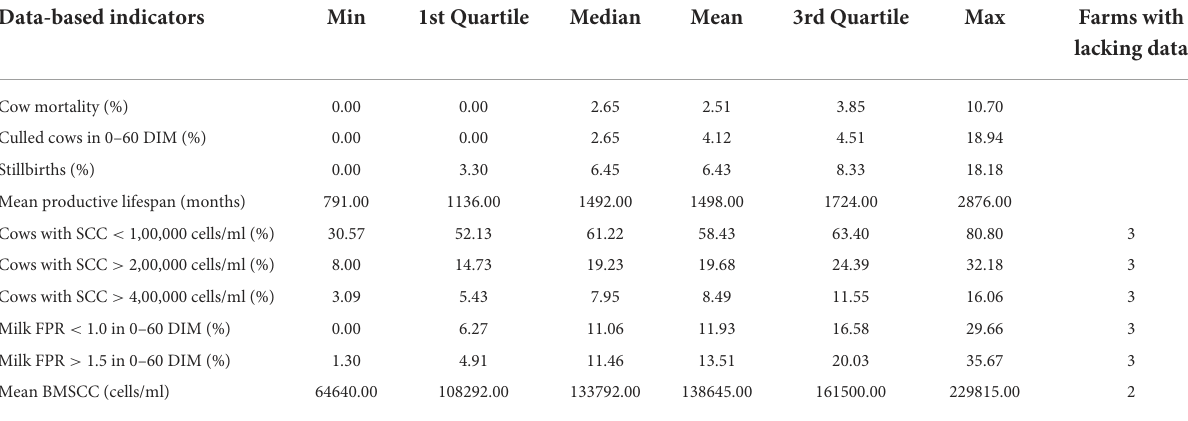
TABLE 3 Descriptive statistics from 10 common data-based indicators calculated from 35 Swiss dairy farms for a 1-year period in advance of the welfare assessments. Data-based